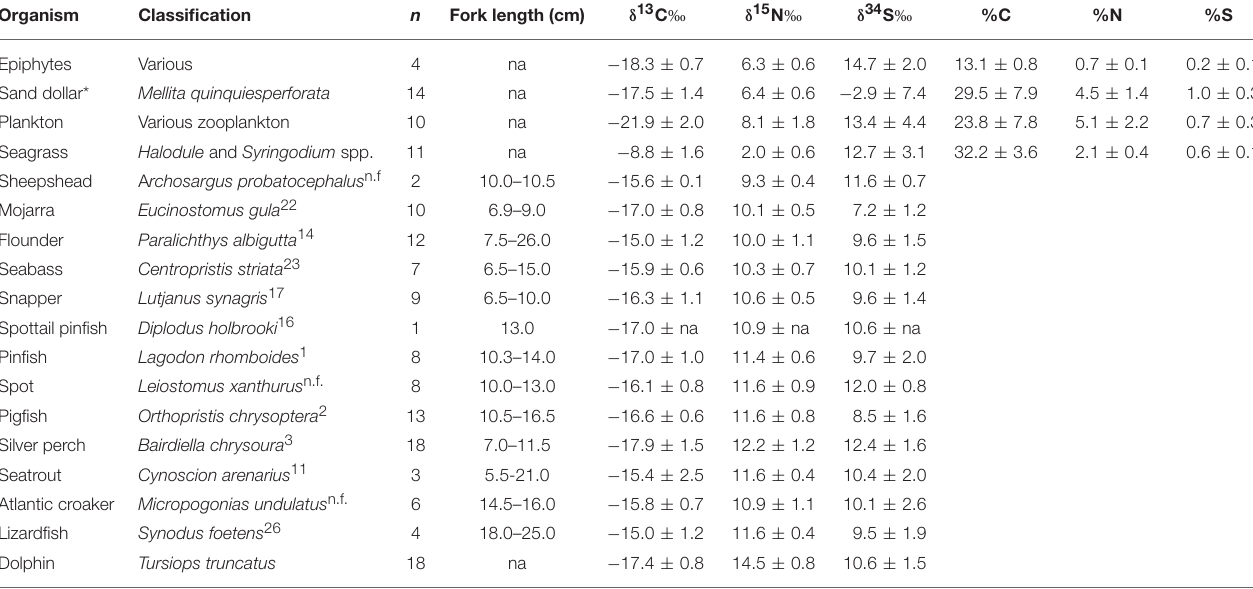
TABLE 1 | Stable isotope abundances in St. George Sound producers and consumers examined in this study.